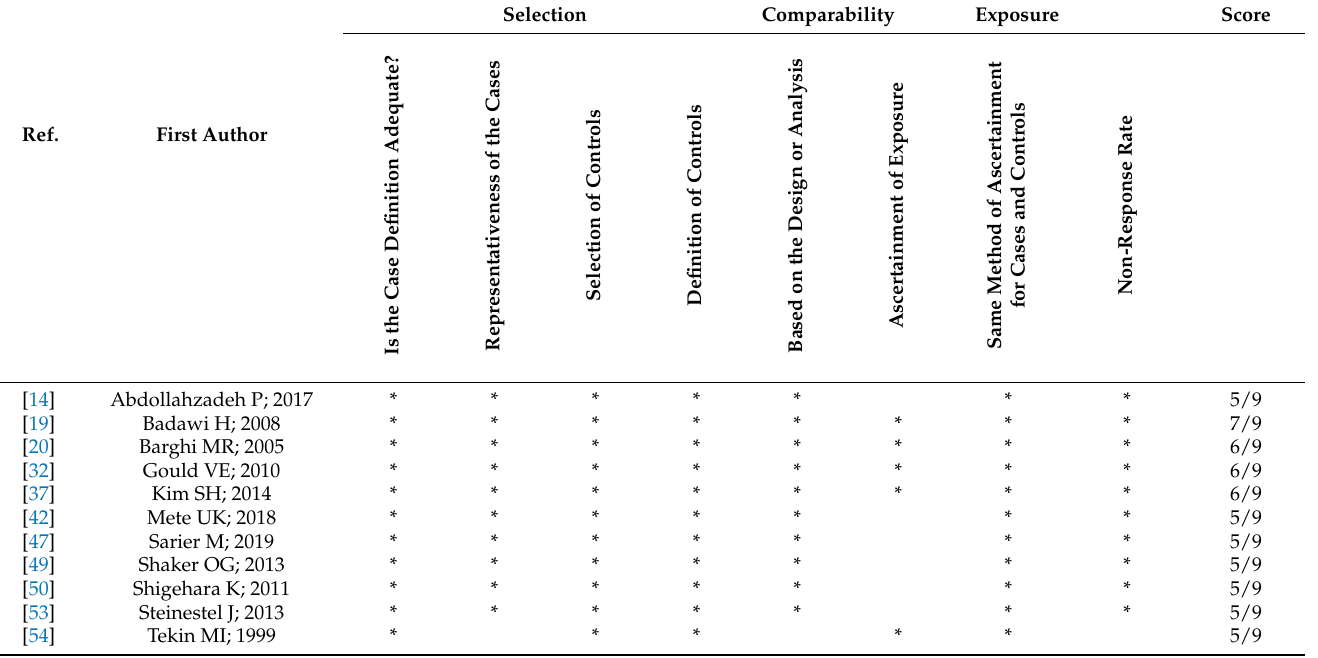
Table 3. NOS quality assessment table. Each study was awarded one star per item within the selection and exposure categories. A maximum of two stars could be awarded for comparability. The score is the sum of the awarded stars and ranges from zero to